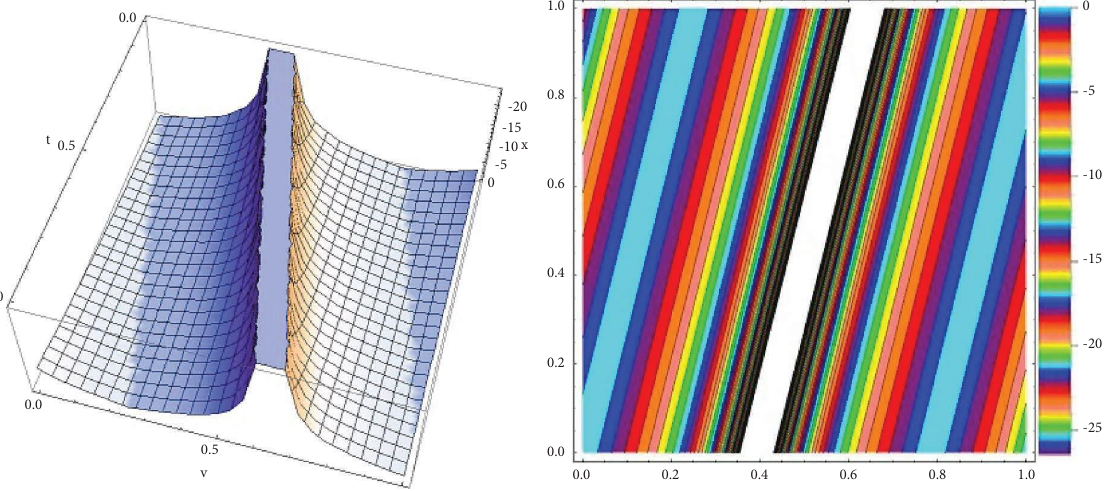
Figure 1: Sketched the singular bell shape soliton from (11) when ω � 5 . 0.